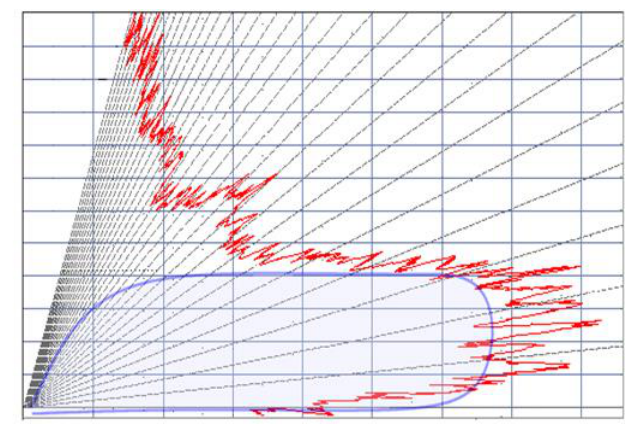
Fig. 2. Cosecant squared antenna pattern